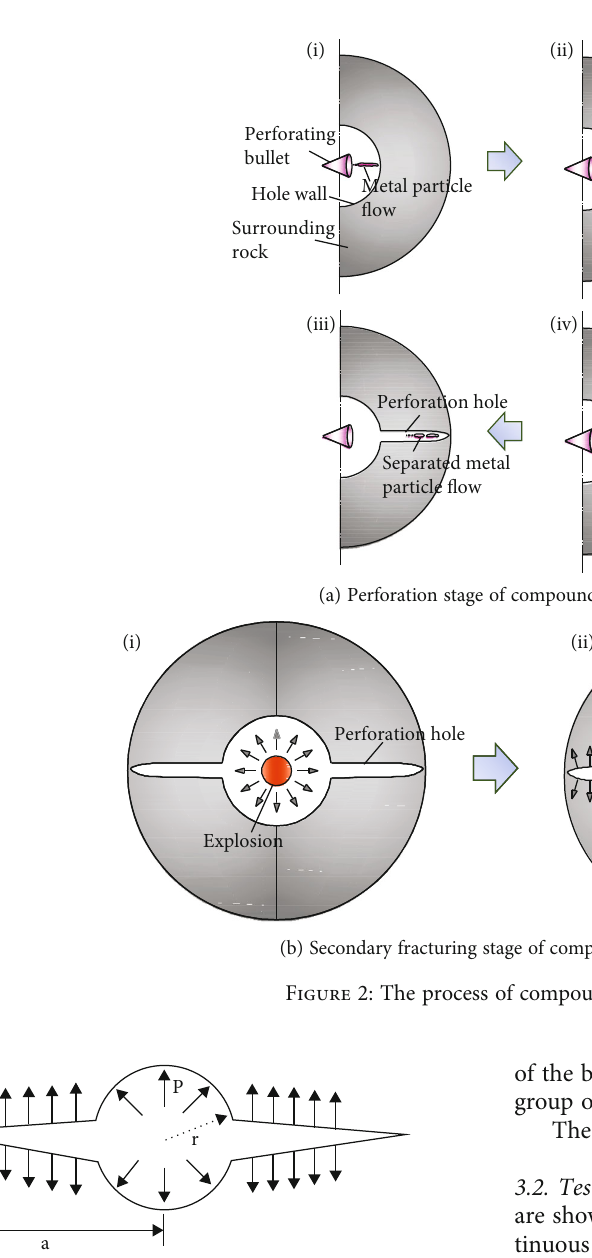
Figure 3: Schematic representation of fracture